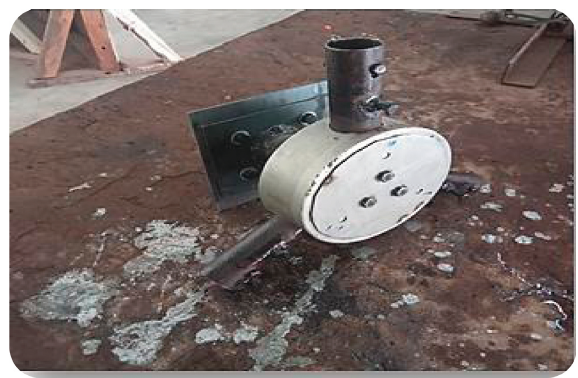
Figure 5: Three-blade rigid rotor